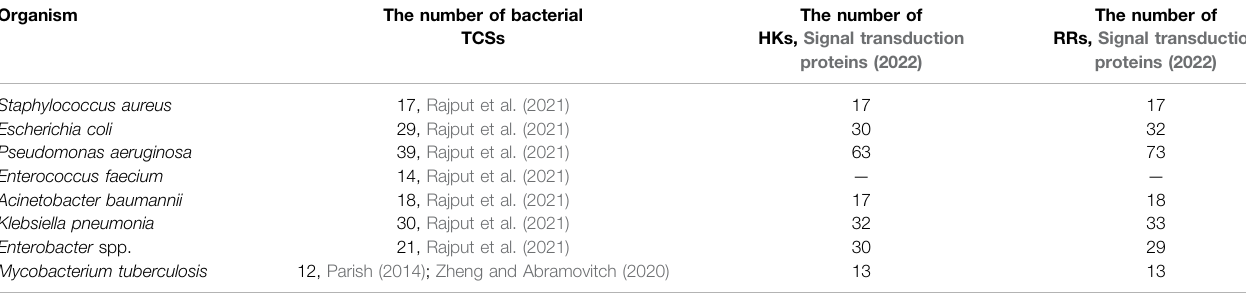
TABLE 1 | The number of bacterial TCSs, HKs, and RRs in important human pathogens (Rajput et al., 2021). Organism The number of bacterial